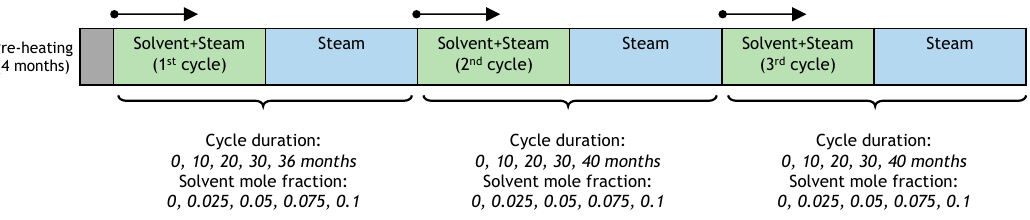
Figure 16. Changes in the duration and solvent concentration for each of the steam-solvent cycles.